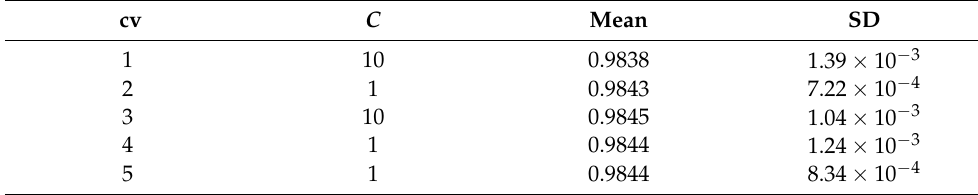
Table 9. Best support vector machine model by